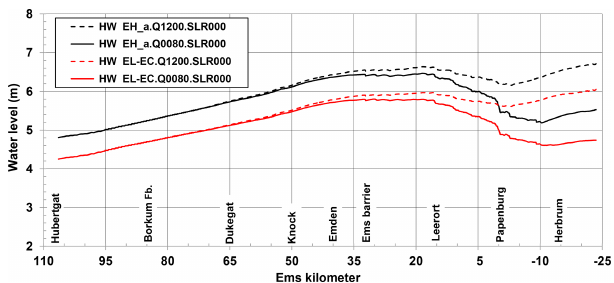
Figure 9. Highest water levels along a longitudinal profile in the Ems estuary during EH_a (black lines) and EL–EC (red lines) for Q = 80m 3 s − 1 (solid lines) and Q = 1200m 3 s − 1 (dashed lines) for an open storm surge barrier without SLR.